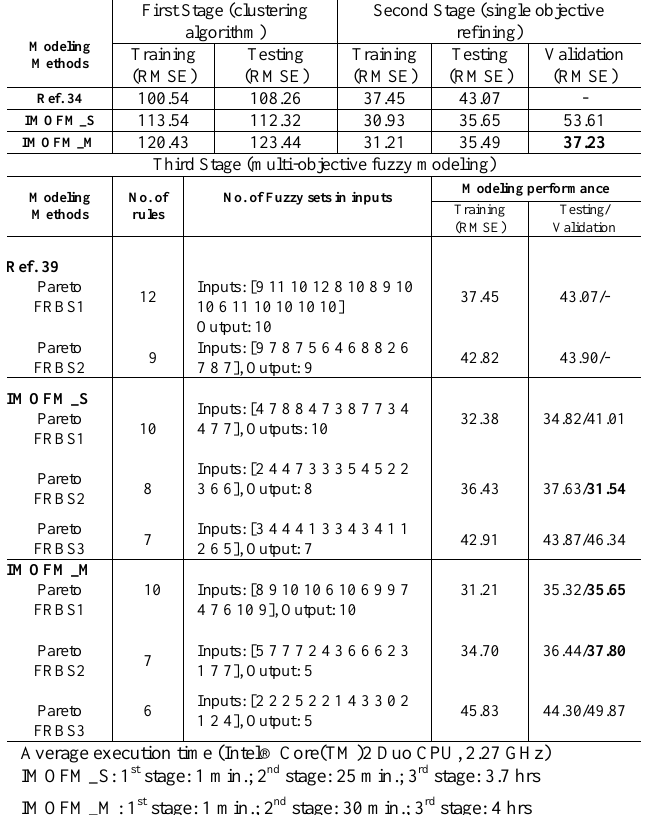
Fig. 19. The Pareto FRBSs at different iterations.